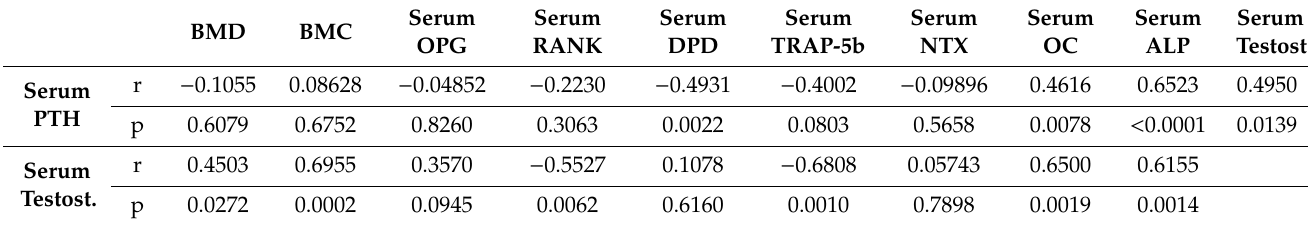
Table 1. Correlations between serum testosterone and PTH and other studied